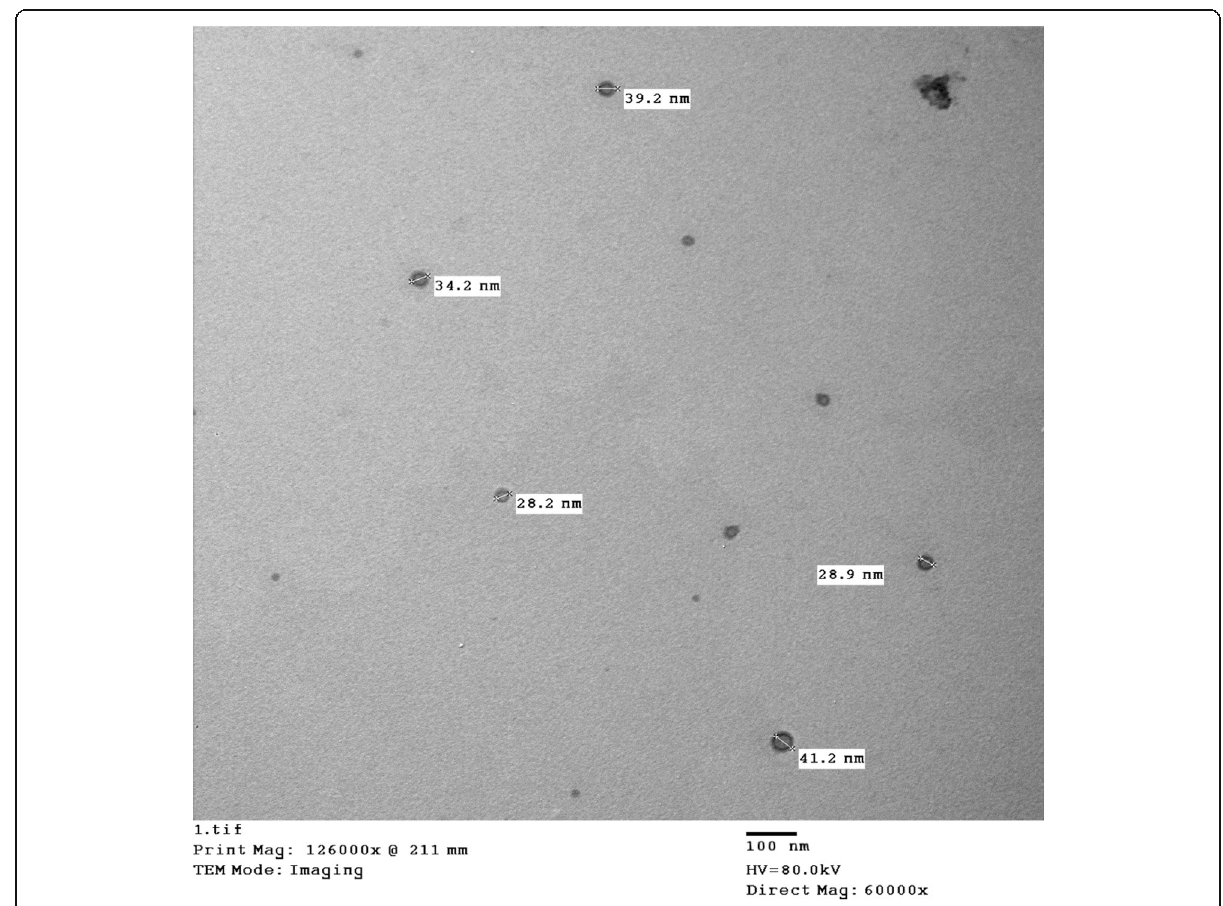
Fig. 2 Nanoparticles of boron trioxide composition average size 35 nm (range from 28 to 41